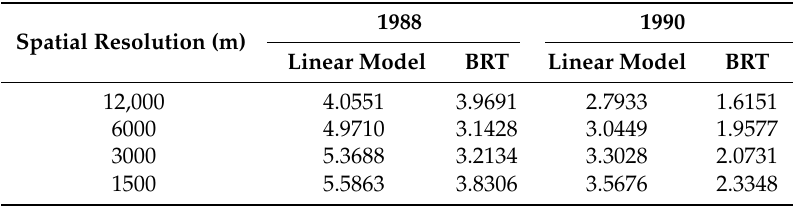
Table 4. Comparison of RMSE of LM and BRT on worst (1988) and best (1990) model fit.